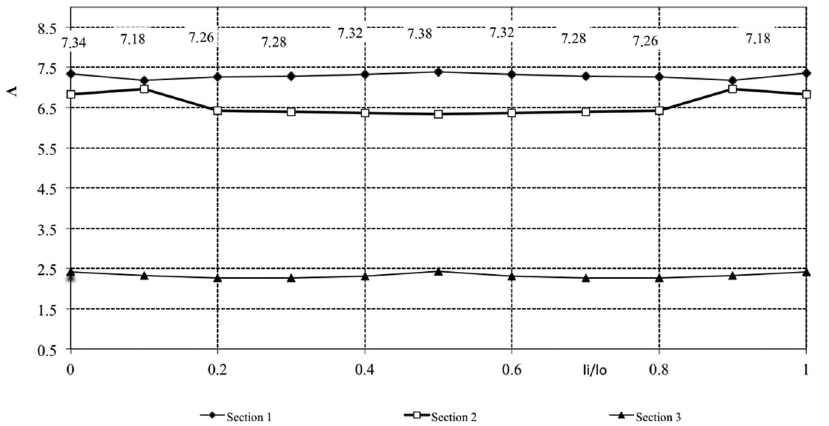
Figure 11: Distribution of Λ on the longitudinal section of workpiece at broach on RFM (section 1 – D i / D 0 ¼ 0.9; section 2 – D i / D 0 ¼ 0.75; section 3 – D i / D 0 ¼ 0.5; l i and D i – distance to a studied point on length and diameter, respectively; l 0 and D 0 – length and diameter of the deformation center, respectively).